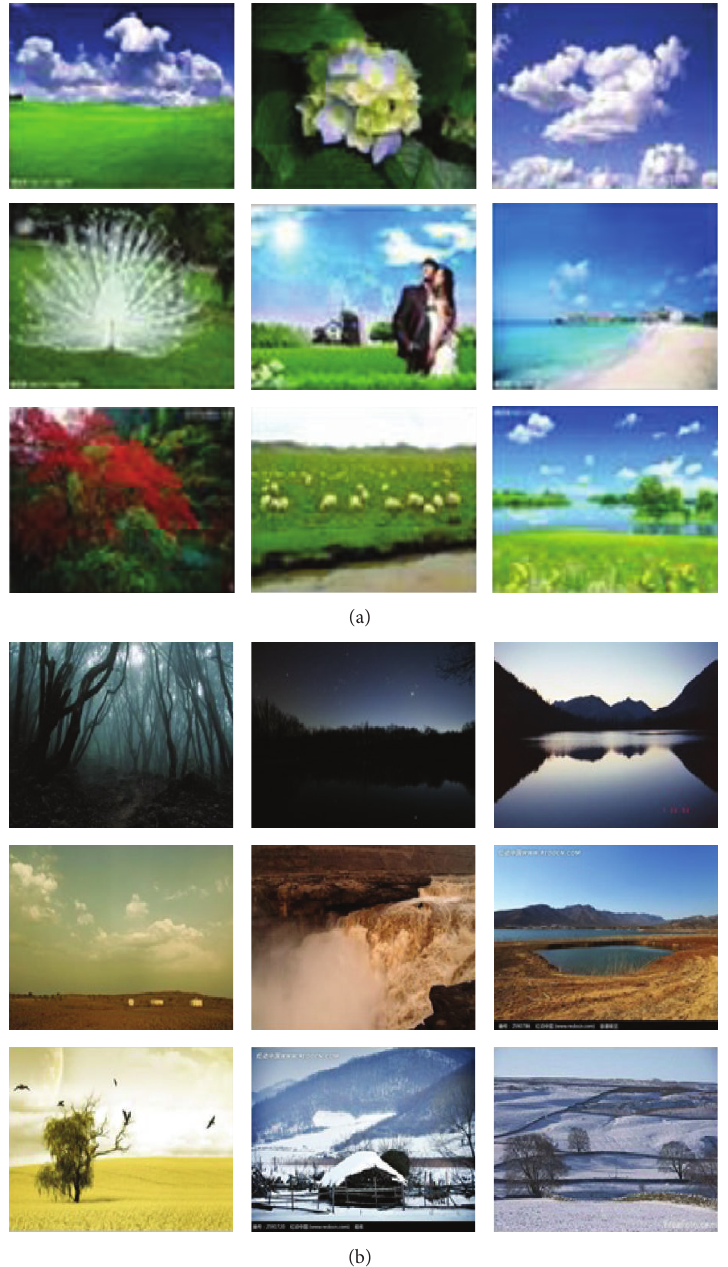
Figure 5: Partial retrieval results for the emotional words “hopeful” and “frustrating,” respectively. (a) Hopeful. (b) Frustrating.